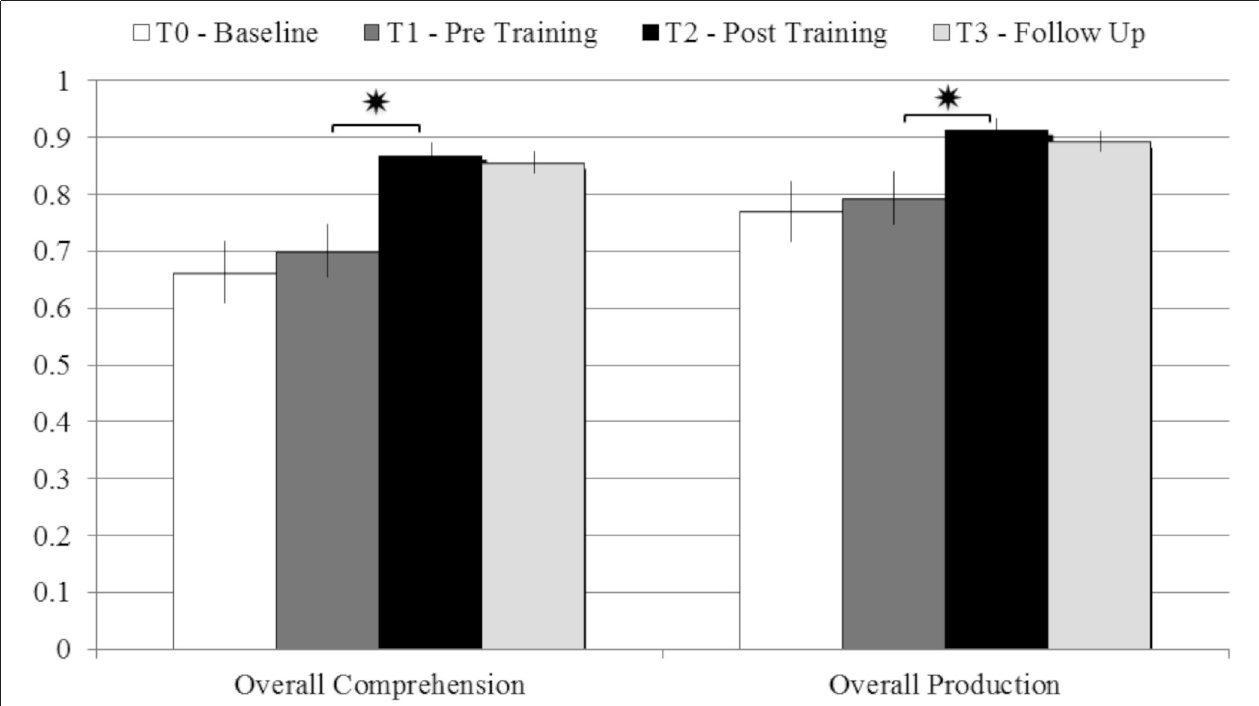
FIGURE 2 | Comparison between the average scores obtained in comprehension and production tasks at T0 – Baseline; T1 – pre Training; T2 – post Training; T3 – Follow-up, with error bars representing standard error. ∗ p <